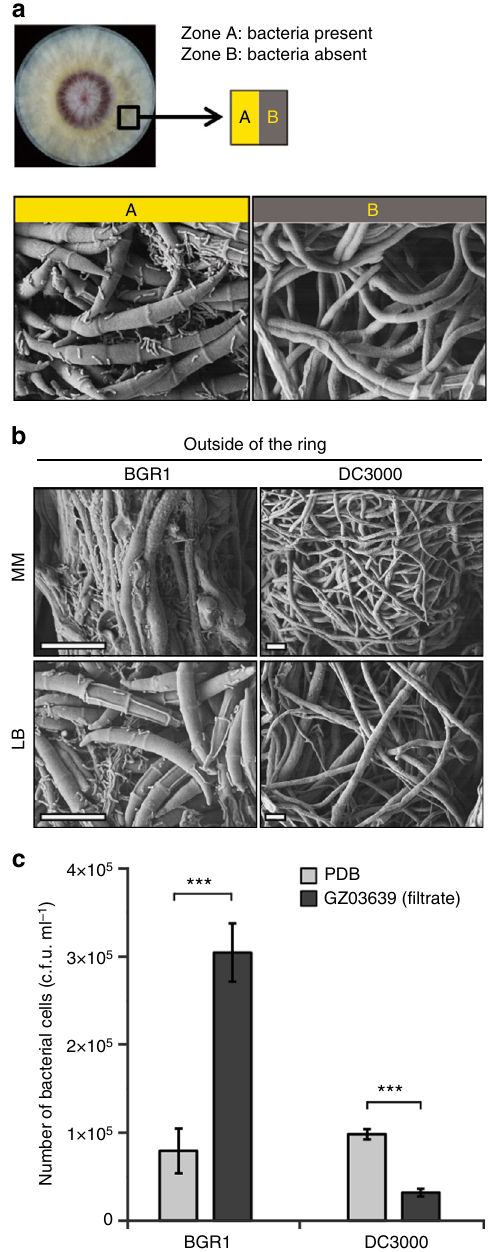
Fig. 5 Physical association between Bg and Fg. a Bacteria and fungi were co-inoculated inside a culture plate (35×10mm) containing LB agar for up to 10 d in the dark at 30°C. A fi eld emission scanning electron microscope detected spores in the zone where bacterial cells were present (A) and not in the zone where bacterial cells were absent (B). Scale bar, 10 μ m. b Physical association between Fg and Bg. The negative control DC3000 did not show transported hyphae outside of the ring. c Capillary tubes fi lled with PDB or GZ03639 fi ltrate were placed into the wells of 96-well plates containing BGR1 or DC3000 bacterial cells. After incubating the plates at 30°C for 3h, liquid in the capillaries were spread onto LB agar plates and colonies formed after 24h were counted. The experiment was repeated twice with three replicates per sample and data presented are the mean ± s.d. (ANOVA; *** P <